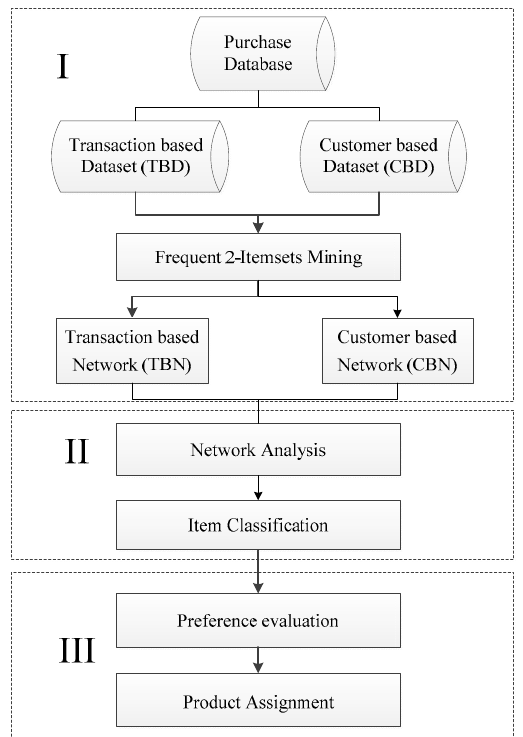
Figure 1. Proposed three-stage method.